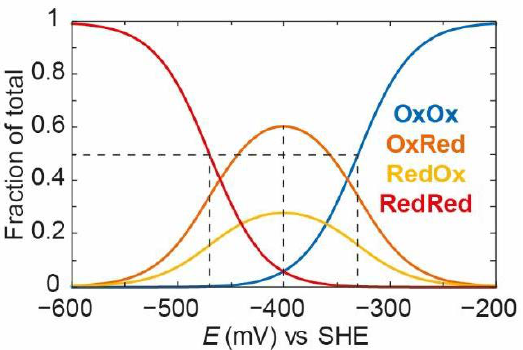
Figure 12. Variation of the fraction (out of 1) of the oxidised ( OxOx , blue), partially reduced ( OxRed , dark orange, RedOx , light orange) and fully reduced ( RedRed , red) species as a function of the applied potential. The curves were obtained using Equations (29)–(32), with E O E O = − 460 mV, E O = − 440 mV (i.e., 100 mV of redox anti-cooperativity), giving an average E O of 3 4 − 400 mV, for a comparison with Figure